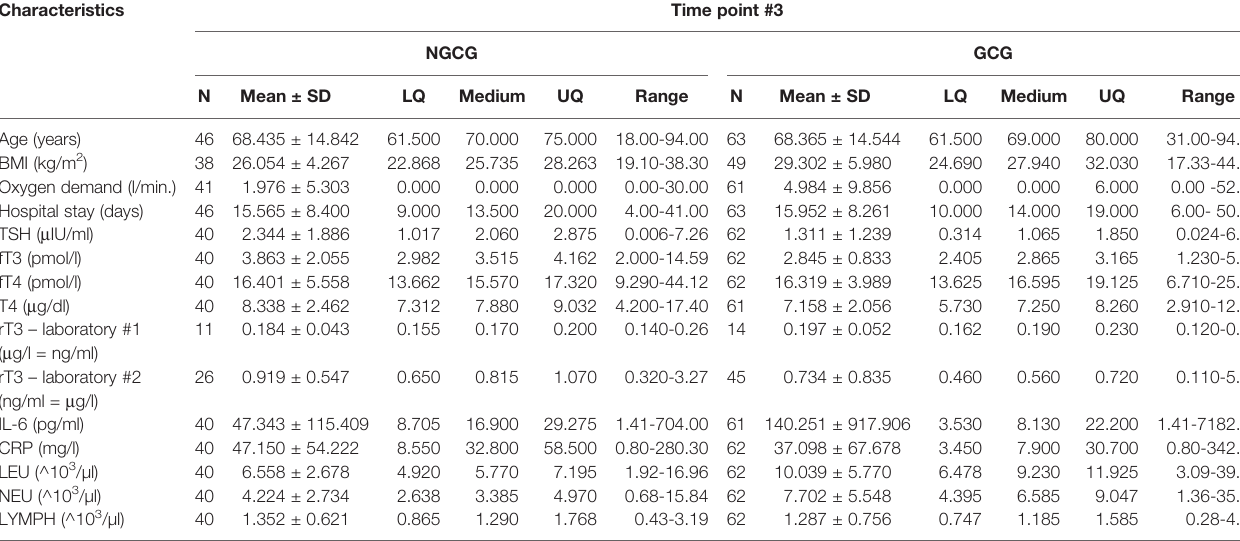
TABLE 5 | Chosen clinical and laboratory parameters – time point #3.